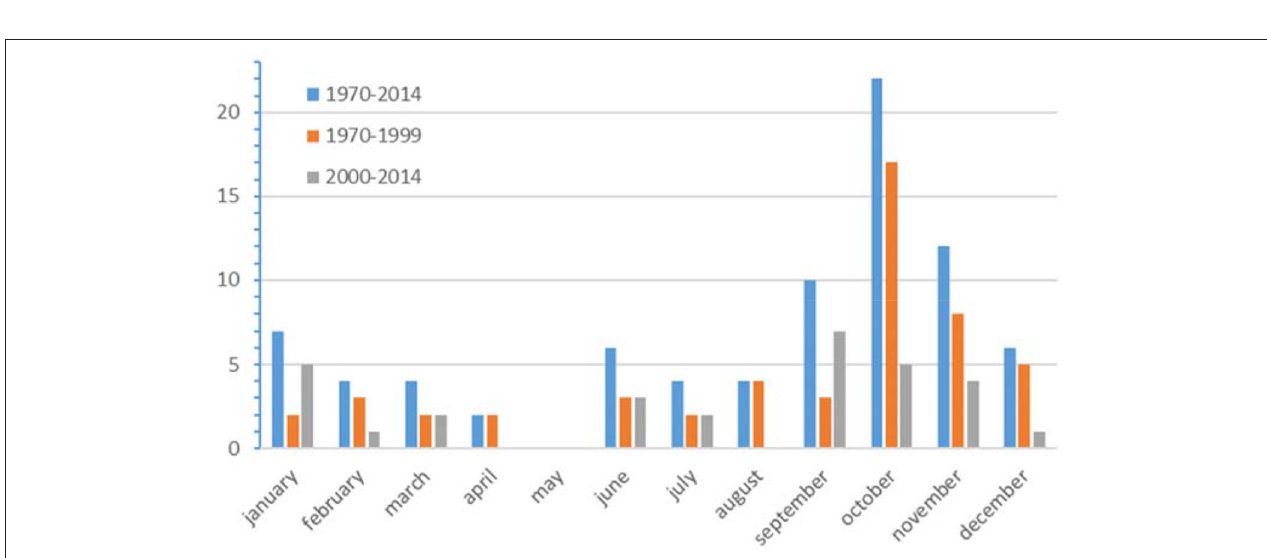
FIGURE 5 | Bi-logarithmic diagram of threshold classes and cumulated frequency of daily rain